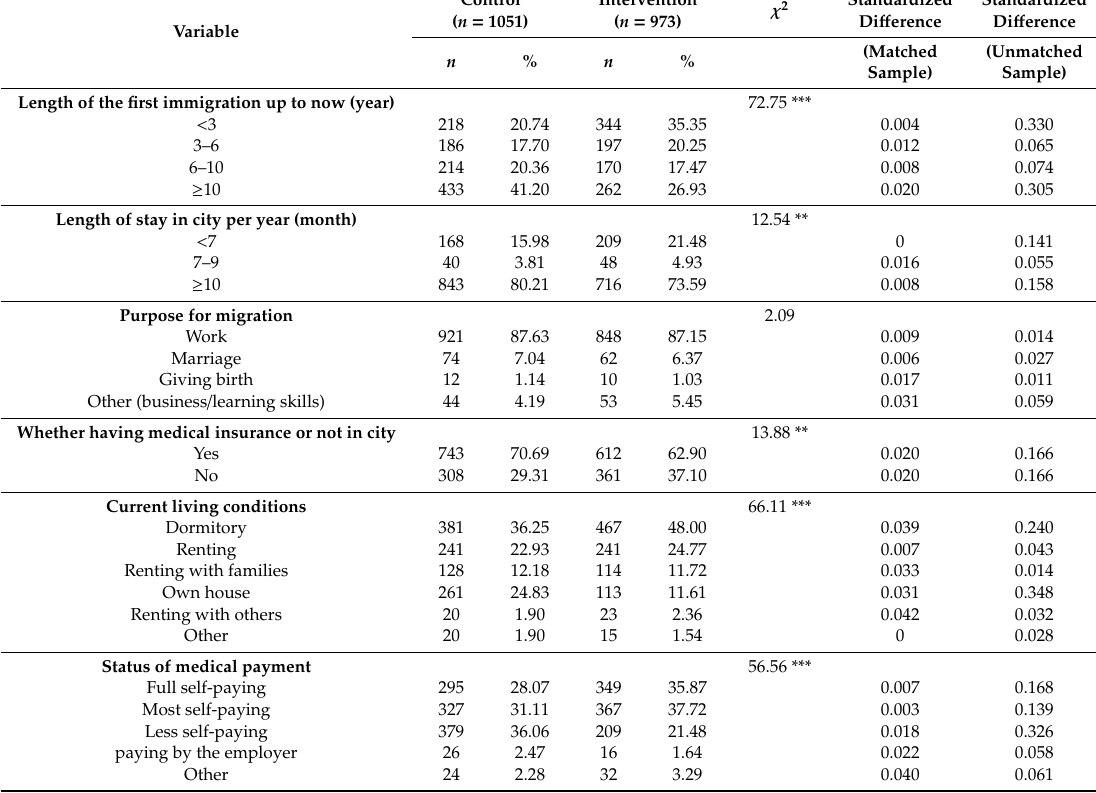
Table A7. Comparison of migration characteristics among participants between intervention and control groups in Chongqing ( n =